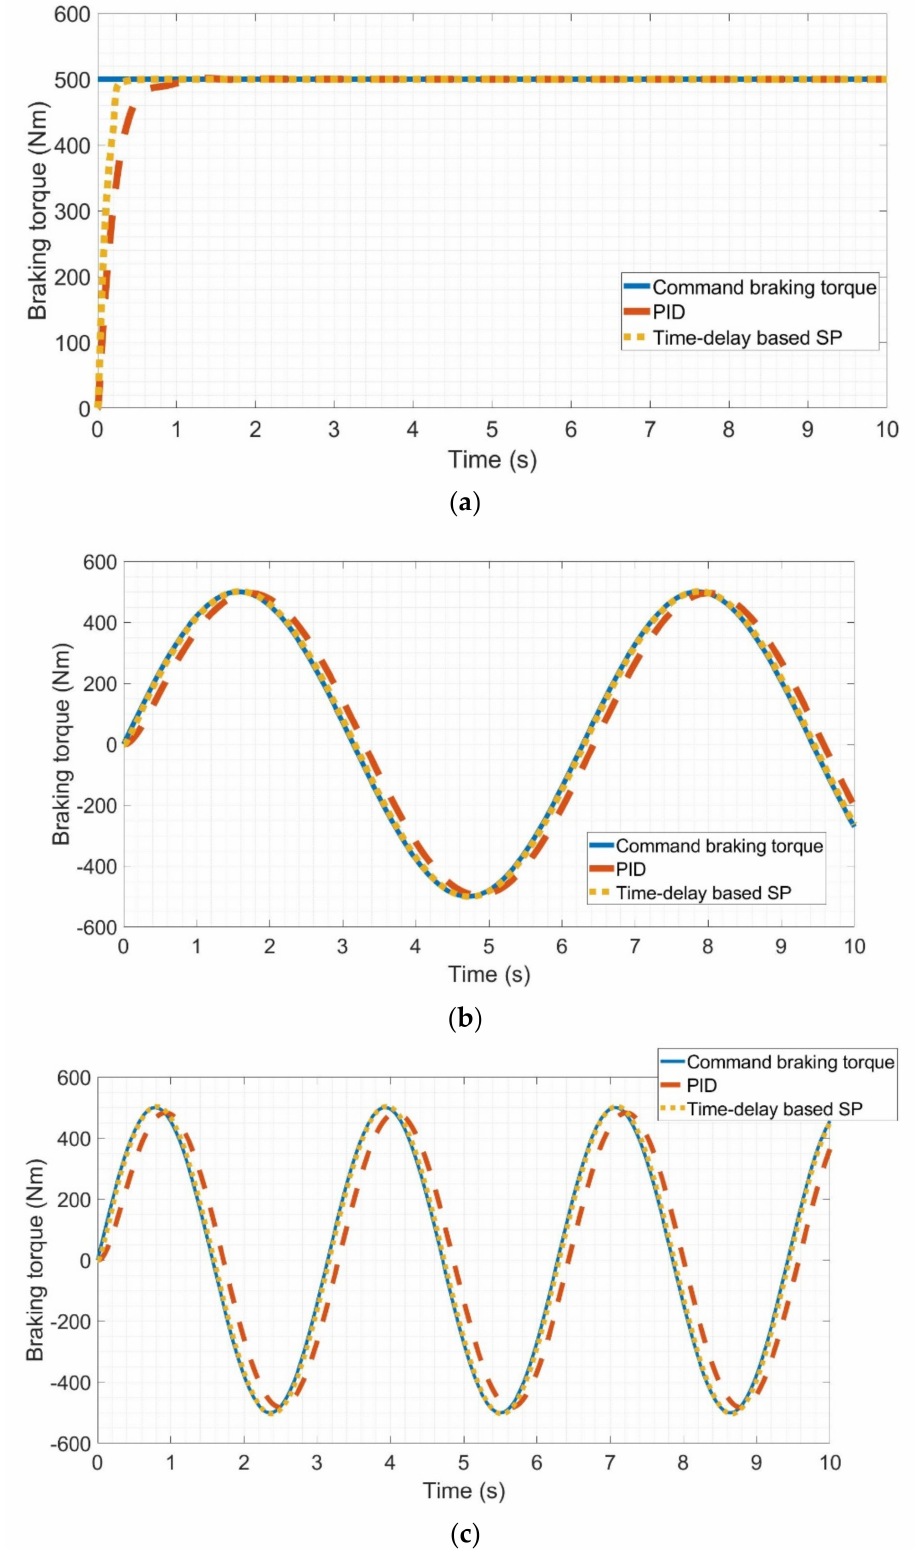
Figure 10. ( a ) Step signal tracking simulation results. ( b ) Tracking simulation results for a sinusoidal signal at 1 rad / s . ( c ) Tracking simulation results for a sinusoidal signal with 2 rad / s